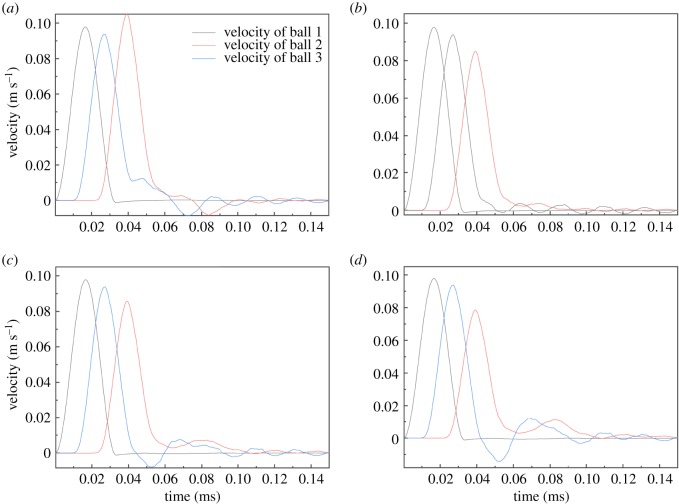
Velocity of three monitored balls with different inhomogeneous coefficients β: (a) 0.4, (b) 0.5, (c) 0.6 and (d) 0.7.